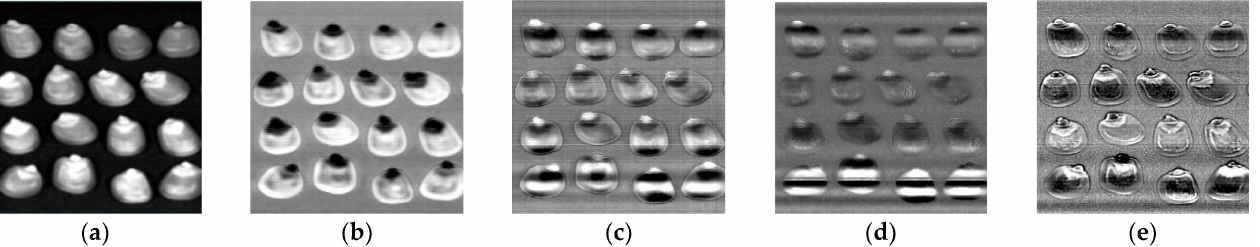
Figure 4. Grayscale images of PC1-PC5 of XY335 endosperm surface hyperspectral image after PCA